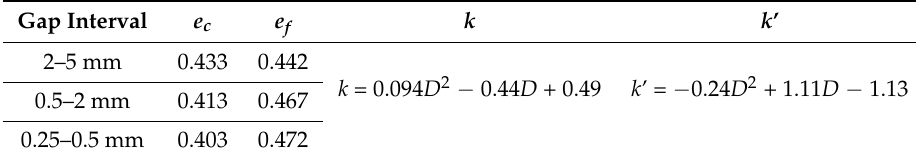
Table 2. Model parameters for the prediction of void ratio of gap-graded SRM with gap intervals of